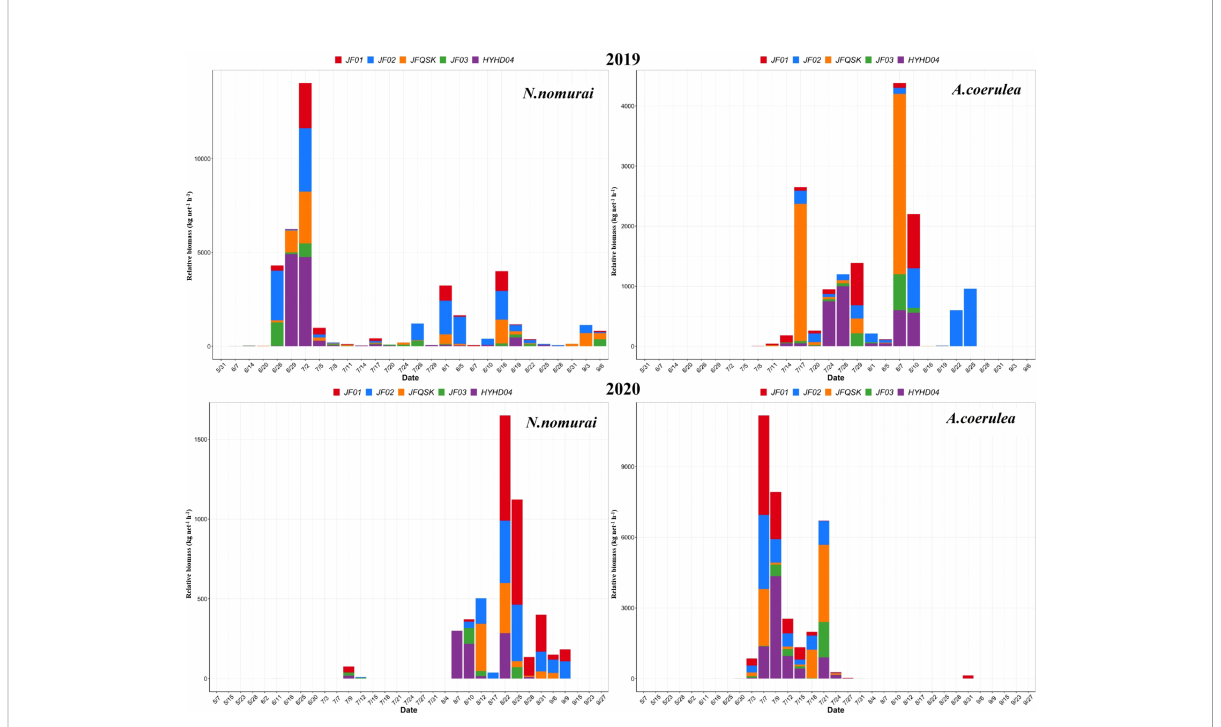
FIGURE 5 The RB of N. nomurai and A. coerulea at the fi ve different stations in 2019 and